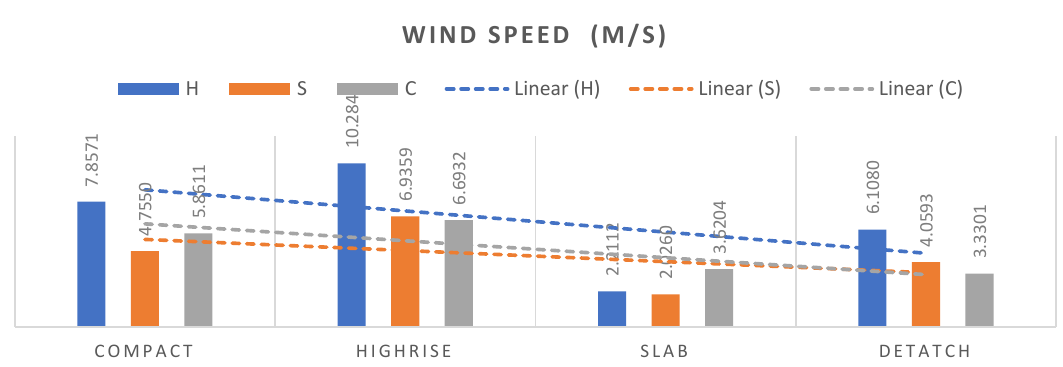
Fig. 14: Comparison of average air temperature from simulation performed on the hottest, coldest and sultriest days of the year between four selected morphotypes